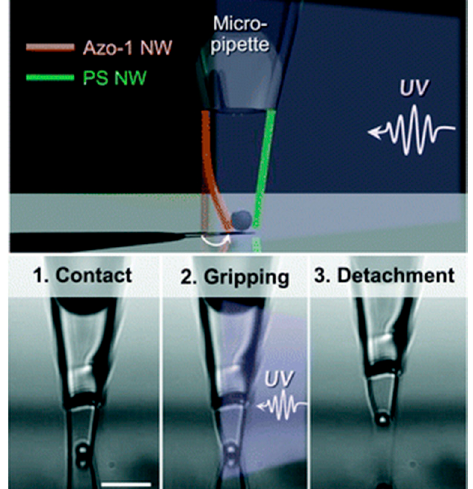
Figure 10. Demonstration of a micro-pipette using azobenzene nanowire of compound 22 . Azobenzene nanowire bends towards the light source and grips a particle; the polystyrene (PS) nanowire is a transparent supporter. Reprinted with permission from [53]. Copyright 2015 Royal Society of Chemistry.